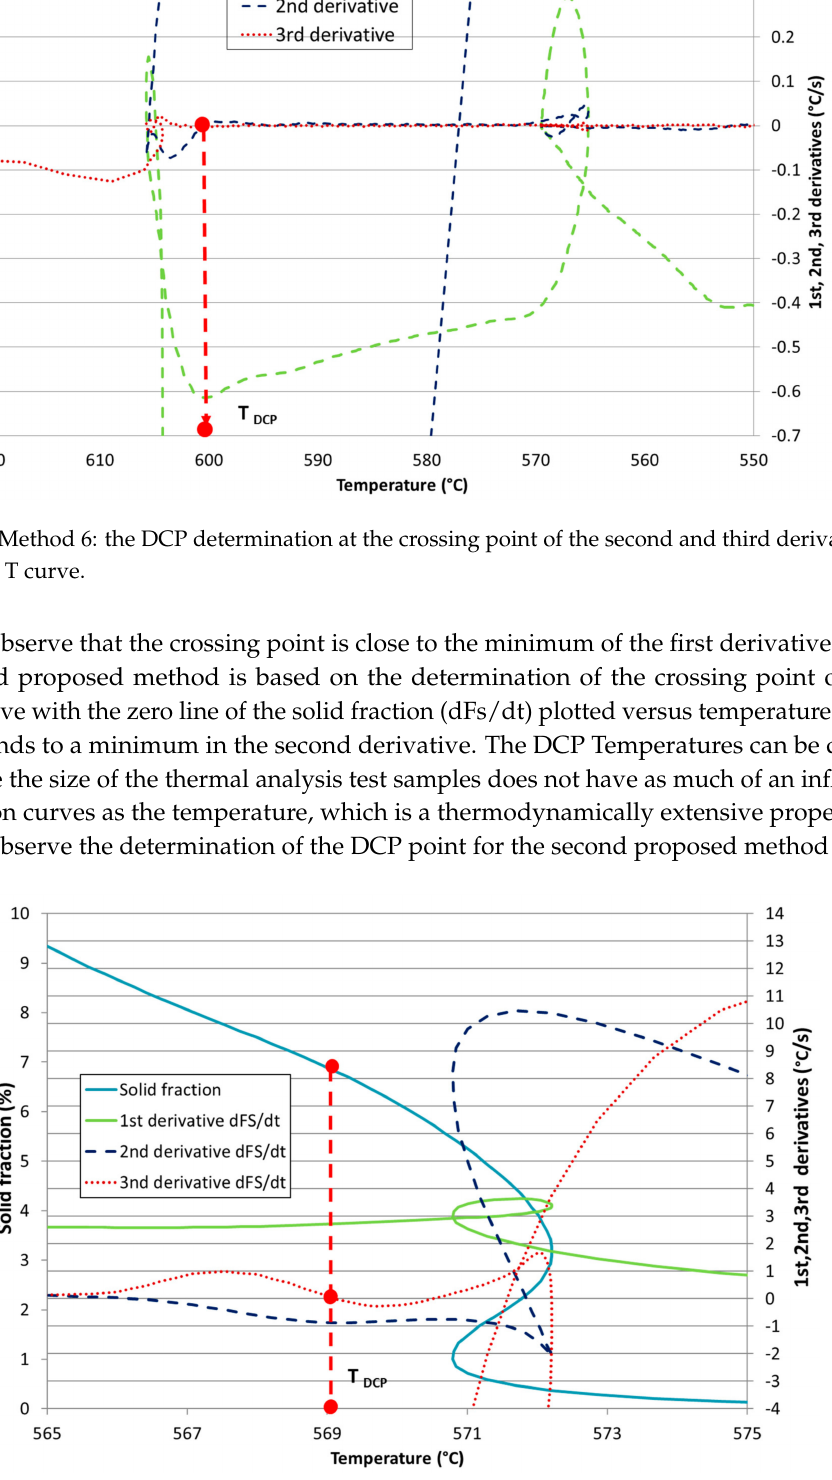
Figure 8. Method 7: the DCP determination at the crossing point of the third derivative of dfs/dt vs. T curve with the zero